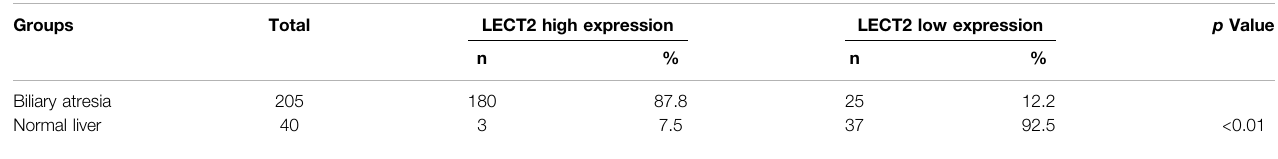
TABLE 2 | Comparison of LECT2 protein expression between biliary atresia liver tissue and control tissue.